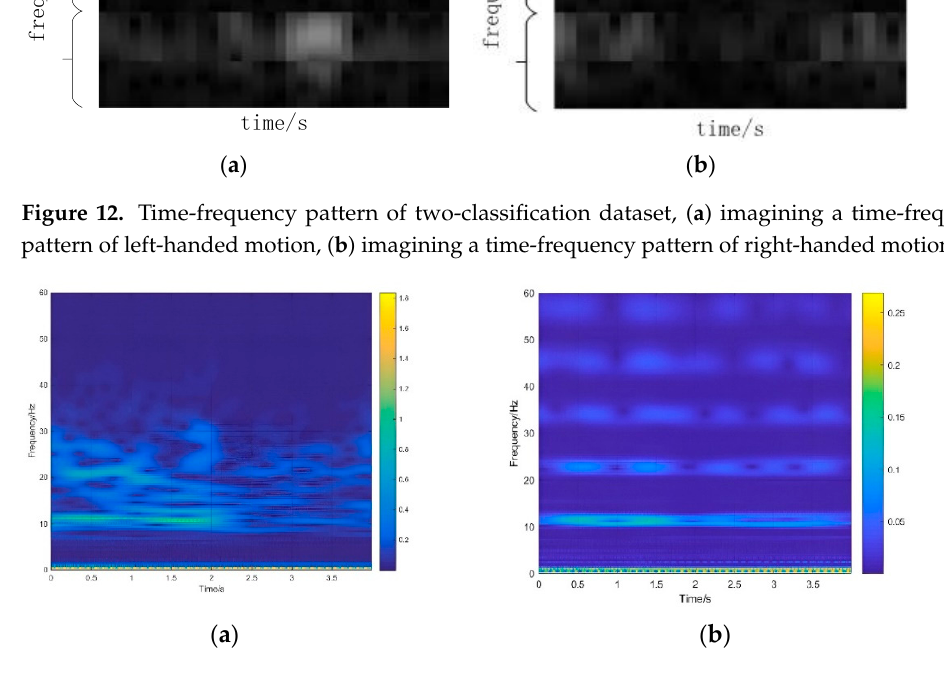
Figure 13. Time-frequency pattern of four-classification datasets, ( a ) Imagining a time-frequency pattern of left-handed motion, ( b ) Imagining a time-frequency pattern of right-handed motion. The EEG signal contains sufficient airspace features in the time-frequency